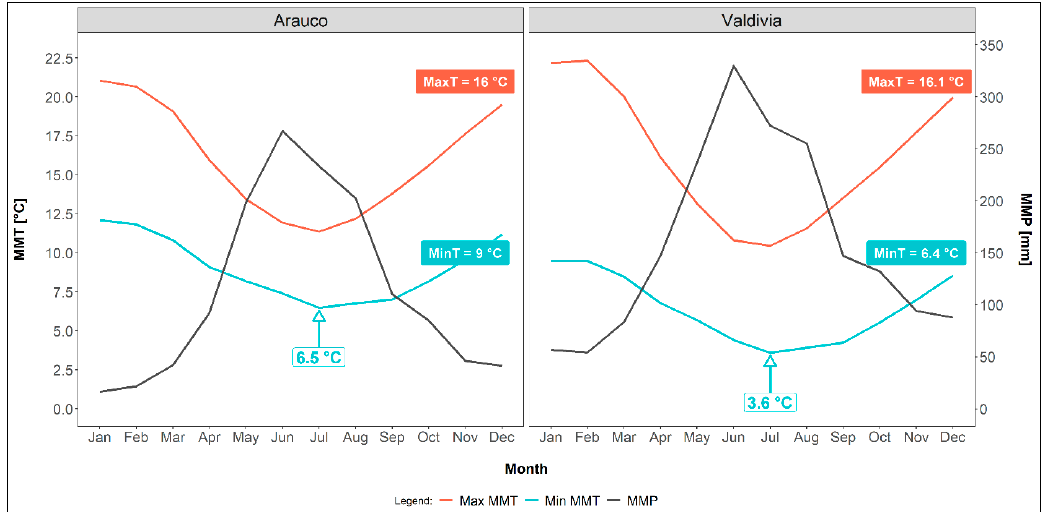
Figure 2. Yearly distribution of temperature and rainfall in Arauco and Valdivia breeding zones with data of 30 years (1987–2017). The primary Y-axis represents the Mean Monthly Temperature (MMT) in °C, and the secondary Y-axis the Mean Monthly Precipitation (MMP) in mm. The orange lines represent the maximum MMT and the blue line minimum MMT (°C). The gray line represents the monthly mean precipitation (mm). The orange label with the title MaxT represents the mean of the maximum MMT, and the blue label the mean of the minimum MMT. The blue arrows in July represent the lowest minimum MMT of the year.